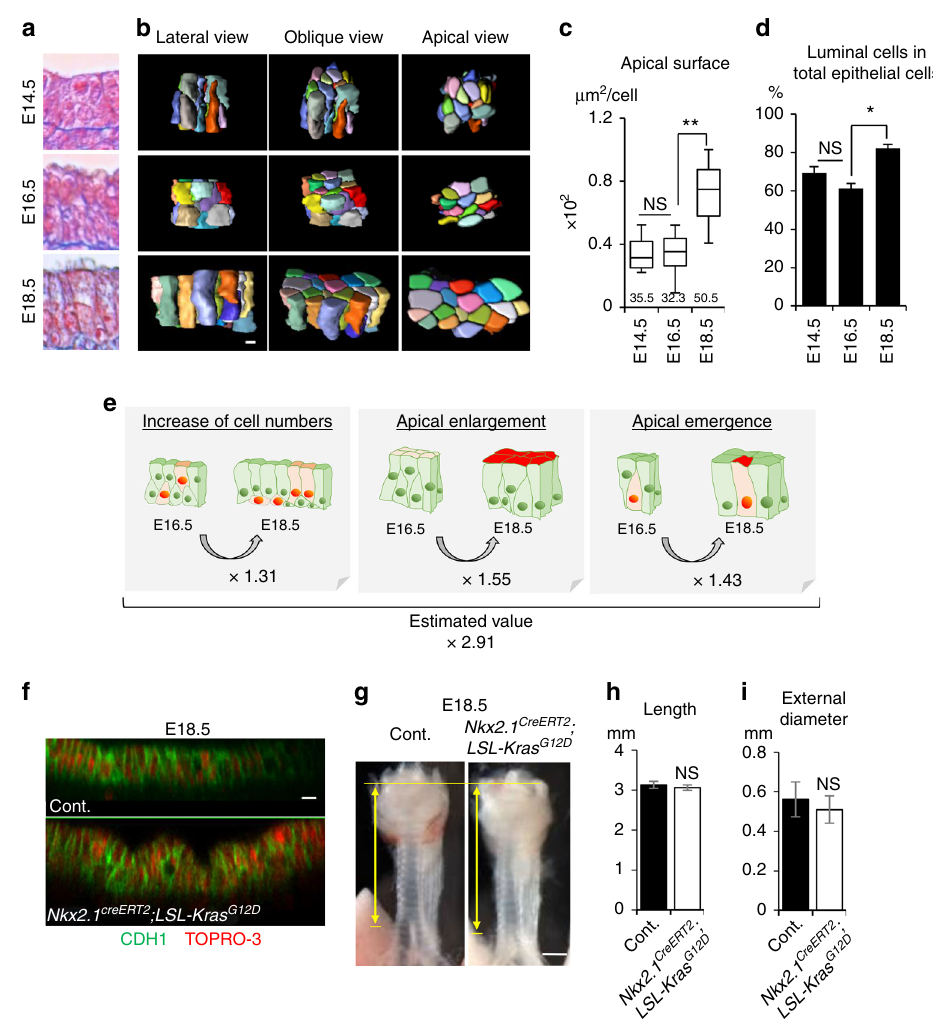
Fig. 2 Low-proliferative luminal-surface enlargement with epithelial rearrangement after E14.5. a Azan staining of developing trachea epithelium. b Representative 3D reconstructed images of an epithelial-cell cluster (25 cells). See also Supplementary Movie 2. c Apical-surface area. Numbers represent means. ( n = 217, 253, and 189 in three embryos for E14.5, E16.5, and E18.5, respectively). center line, box limits, and whiskers represent mean, 25 and 75% con fi dence limits, and min and max values, respectively. d Proportion of luminal cells in total epithelial cells. Data represent means± SEM ( n ≥ 3) ( n = 528, 732, and 1045 in three embryos for E14.5, E16.5, and E18.5, respectively). e Integration of quantitative values revealed that modest increases in cell numbers, apical enlargement, and apical emergence contributed to luminal-surface enlargement. f Optical image of tracheal epithelium in Nkx2.1 CreERt2 ; LSLKras G12D trachea and littermate control at E18.5. Whole tracheas were stained for CDH1 (green) and TOPRO-3 (red). g Gross morphology of Nkx2.1 CreERt2 ; LSL-Kras G12D trachea and littermate control. Yellow arrows indicate trachea length. Tracheal tube length ( h ). External diameter ( i ). Data represent means ± SEM ( n ≥ 3). P values ( ** P < 0.01, * P < 0.05) show the signi fi cance with the Tukey-Kramer method ( c , d ) or Student ’ s t test ( h , i ). NS